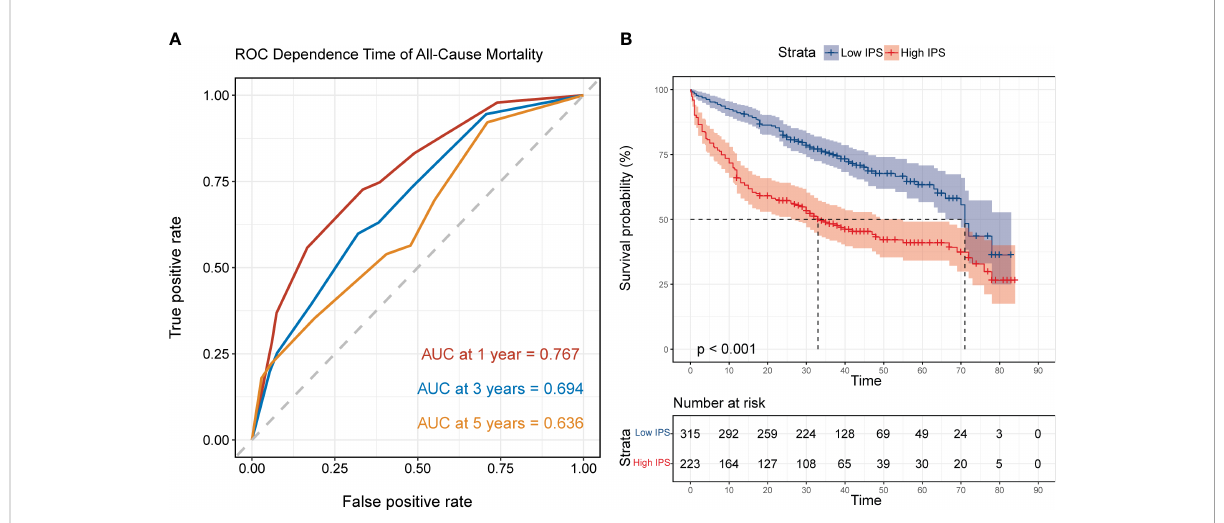
FIGURE 6 The predictive values of in fl ammatory prognostic scoring (IPS). (A) Time-dependent ROC curves showing the area under the curve of IPS predicting all-cause mortality at 1, 3 and 5 years in AHF patients; (B) Kaplan-Meier survival curve of IPS for all-cause mortality in AHF patients, grouped by ROC optimal cut-off values. Low IPS: <0.301 points, n=315; and High IPS: ≥ 0.301 points, n=223.